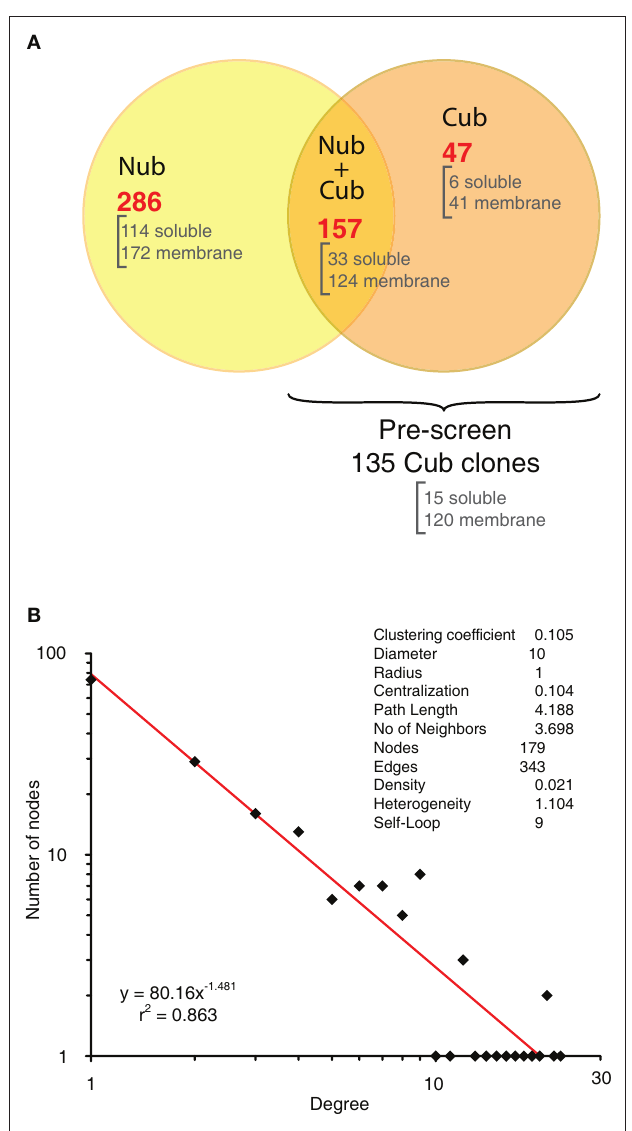
Figure 4 | representation of Nub and Cub clones in AMPv2 network and frequency distribution of the resulting network. (A) The mbSUS screen was performed with 490 genes of which 443 were mobilized into the Nub destination vector and 204 into the Cub destination vector (157 genes were common to both pools). The pPPI network between 179 nodes yielded 343 edges. (B) The power law frequency distribution of the network was obtained with the “NetworkAnalysis” tool of